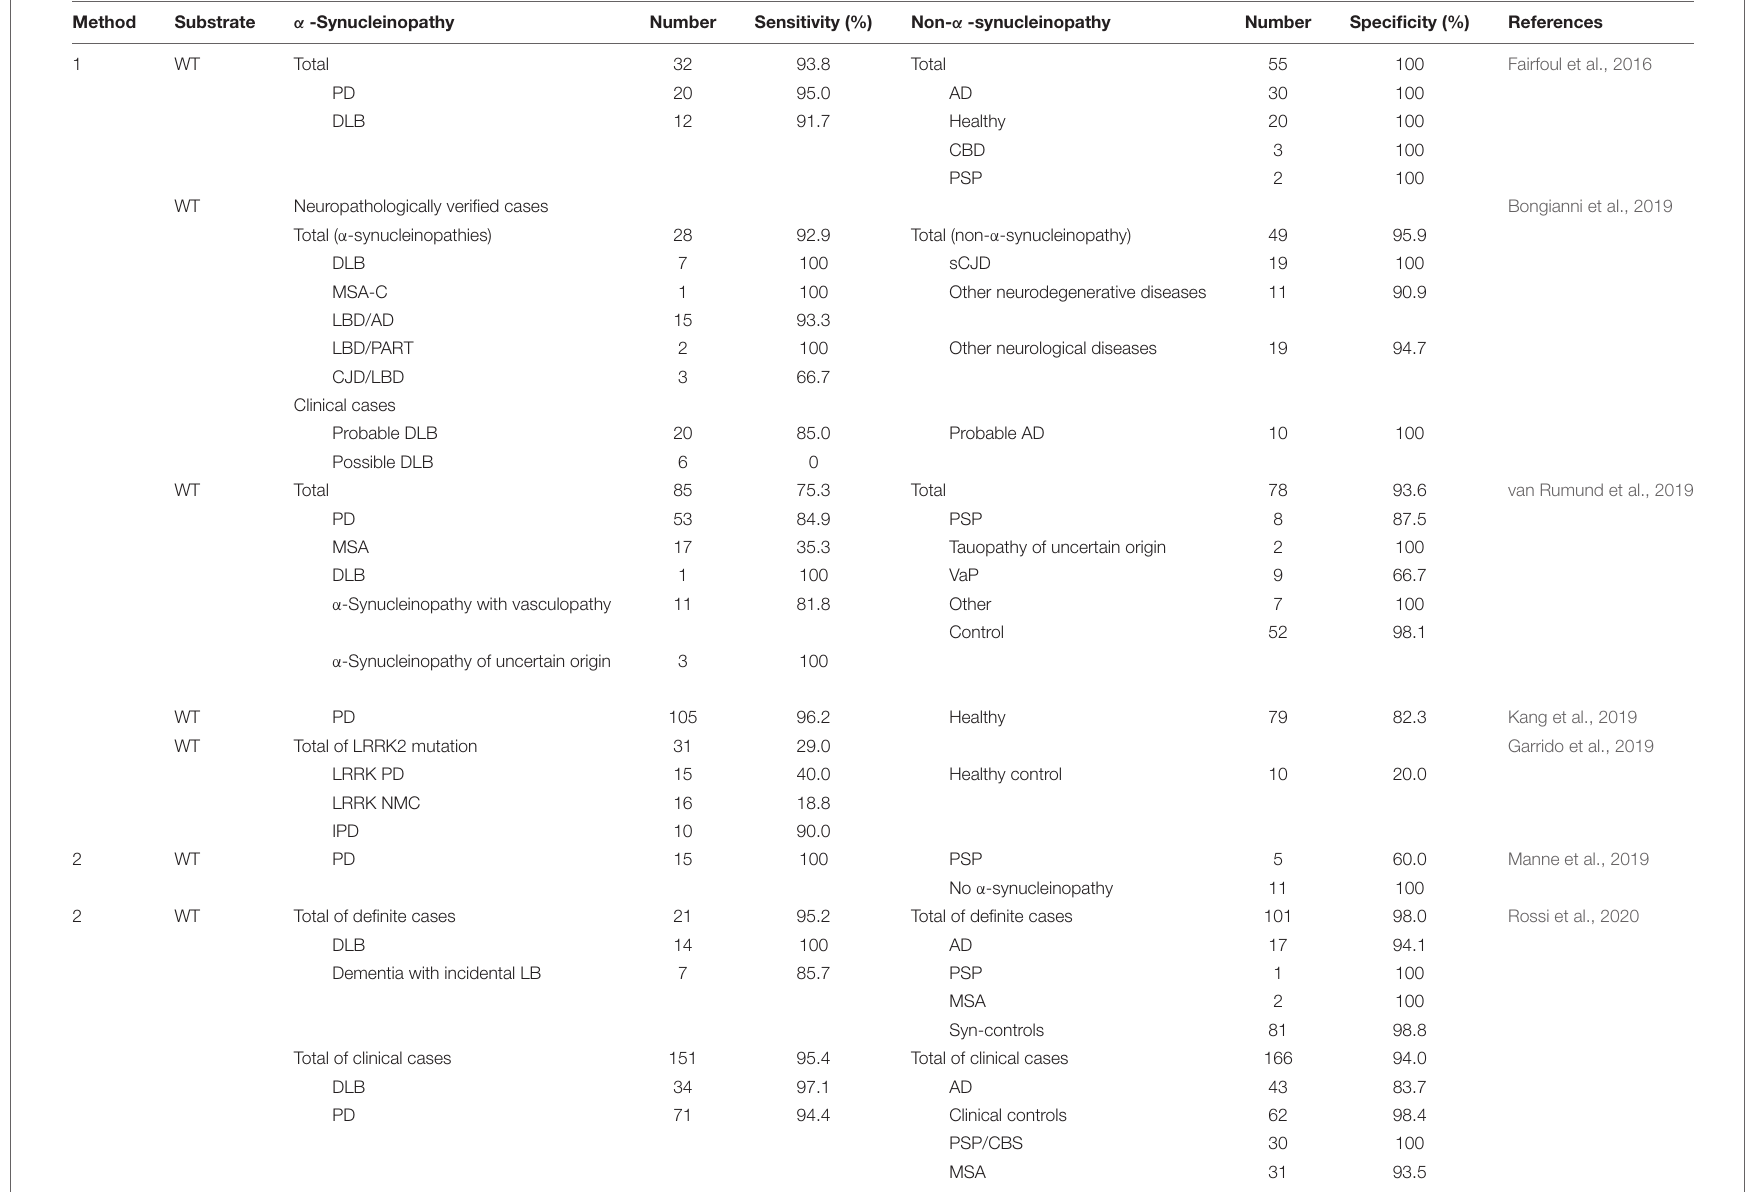
TABLE 1 | Sensitivity and specificity of α -syn RT-QuIC in CSF of